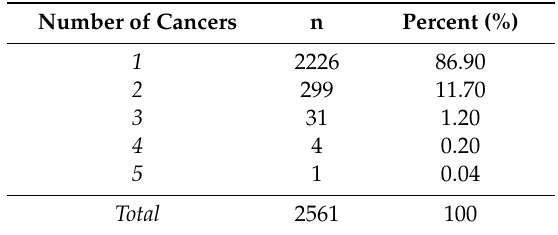
Table 2. Distribution of primary cancer diagnoses per cancer patient.